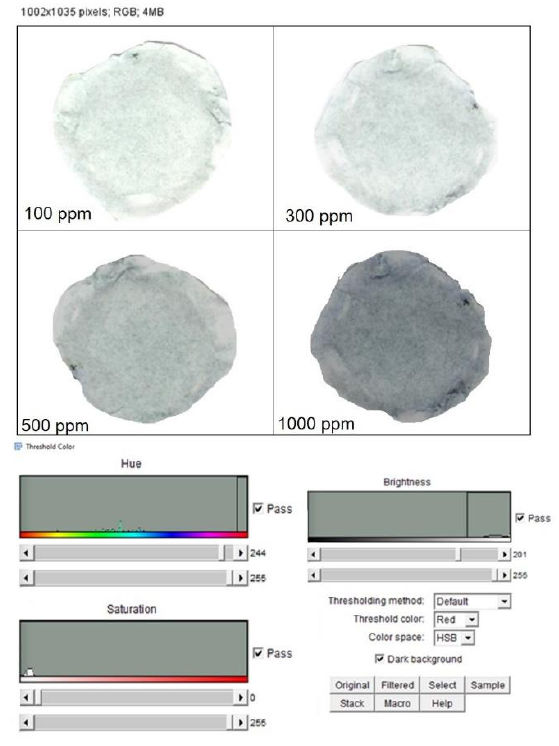
Figure 3. Hue adjustment section of the Threshold Color window in ImageJ analysis software of the NH 3 PAD.